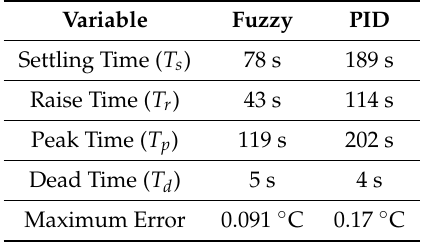
Figure 10. Relationship between the set-point (blue line) and the emulated temperature (red line) for the step response of a PID controller. Table 4. Step response parameters for each